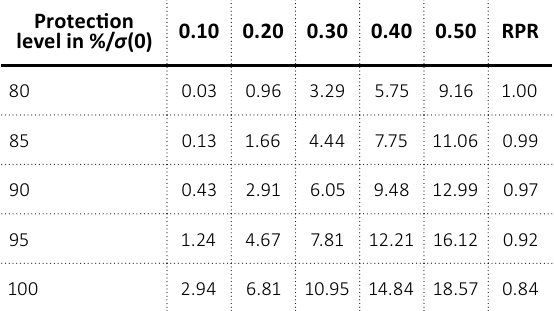
Table 2. American put option prices with the pure risky asset as an underlying Protection level in %/ σ (0)